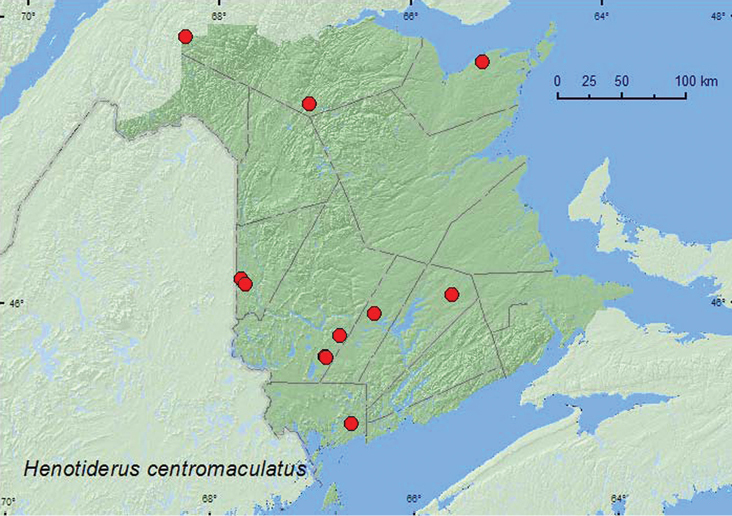
Collection localities in New Brunswick, Canada of Henotiderus centromaculatus.